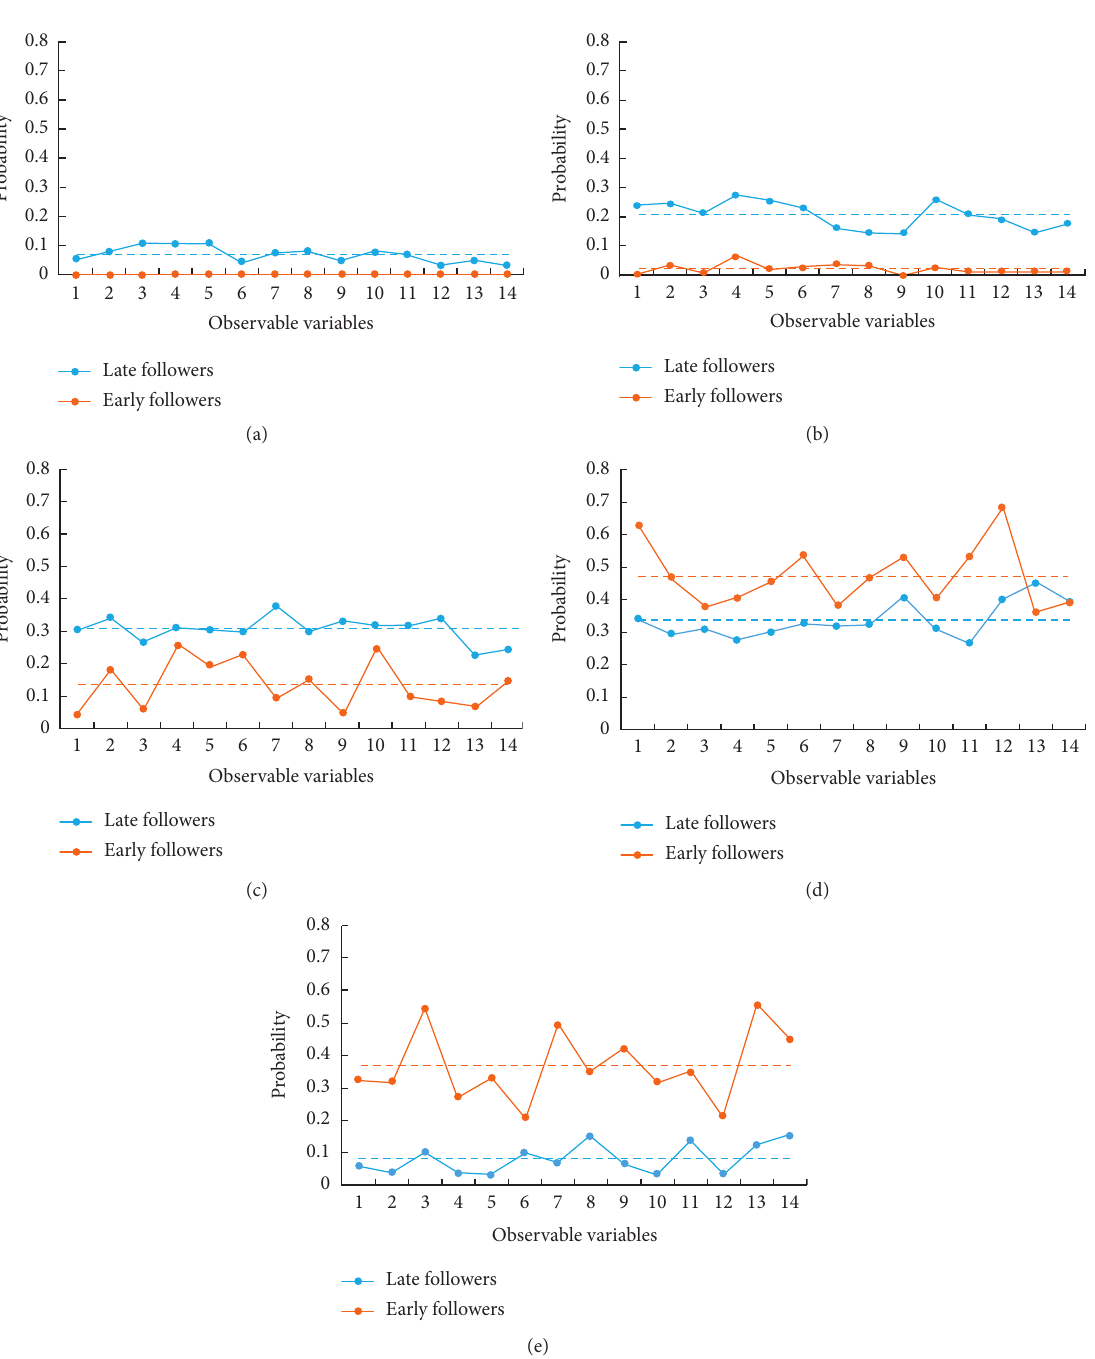
Figure 4: Conditional probability of LCA based on 2019 data. (a) Strongly disagree. (b) Disagree. (c) Neither agree nor disagree. (d) Agree. (e) Strongly